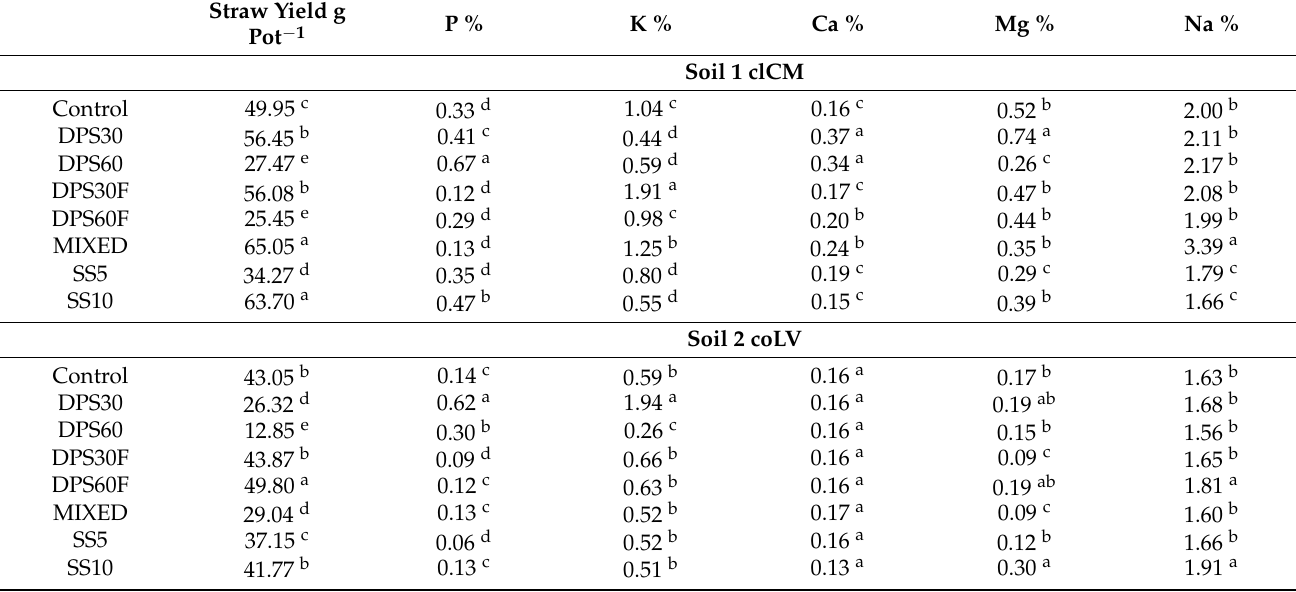
Table 7. Wheat straw yield and selected elemental composition as affected by deinking paper sludge application. Straw Yield